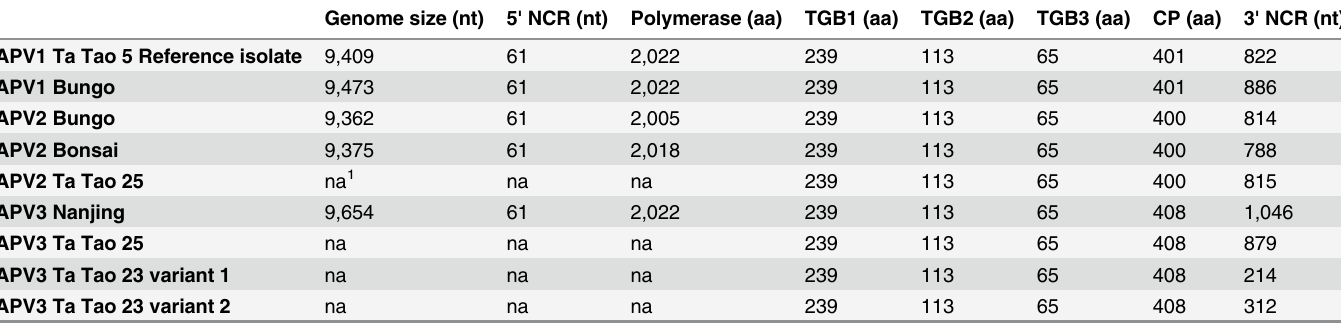
Table 1. Size of the genome, 5' and 3' non coding regions and open reading frames encoded by the genome of Asian prunus virus 1, 2, and